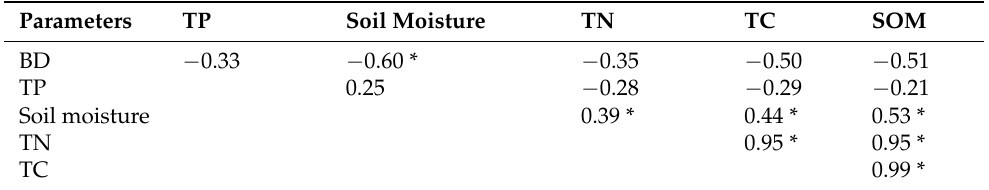
Table 2. Pearson’s (two-tailed) correlation analysis between different physicochemical soil properties (bulk density, BD; total P, TP; total N, TN; total C, TC; soil organic matter, SOM) for all NESS sites